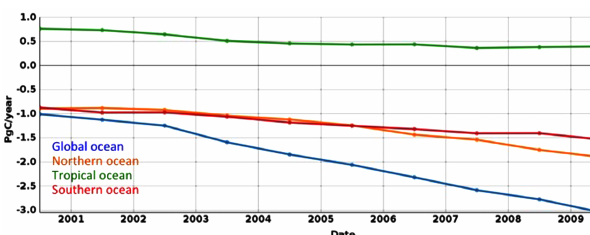
Figure A1. CO 2 air–sea fluxes including the natural ocean out- gazing, used as input to the ORCHIDEE-CCDAS and estimated from a neural network approach using observed p CO 2 data (see main text, Sect. 2.5.1). The northern, tropical and southern ocean contributions to the global ocean flux (blue curve) are also provided.